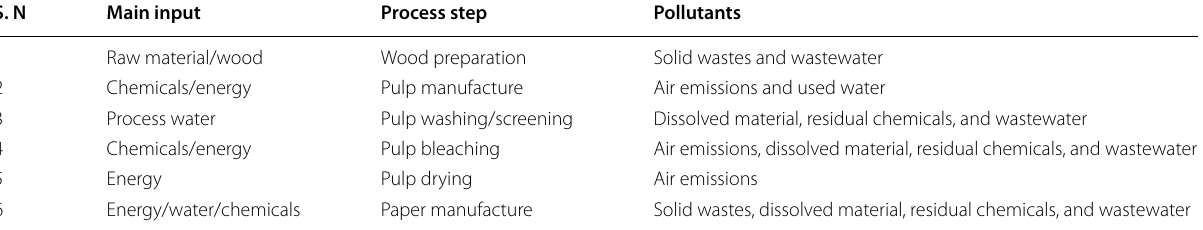
Table 5 Potential pollutants from pulp and paper mill waste S. N